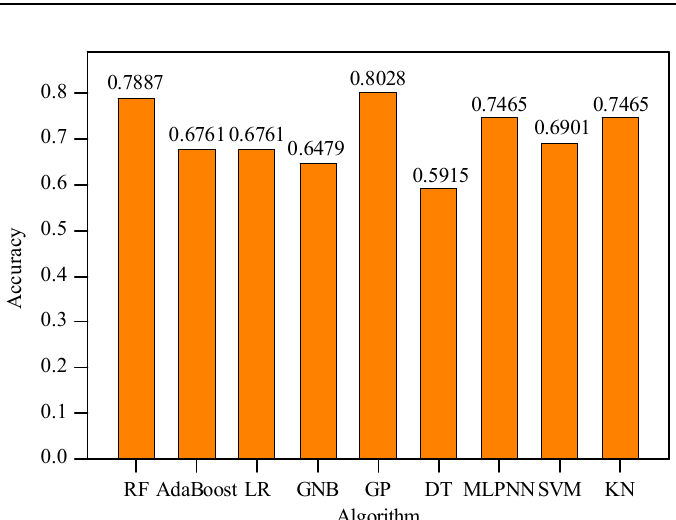
Figure 12. Accuracy of each comparison algorithm.